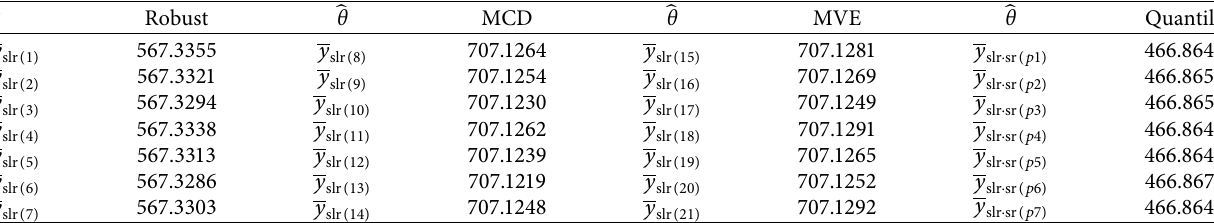
Table 4: MSE for population-2 (nonsensitive).